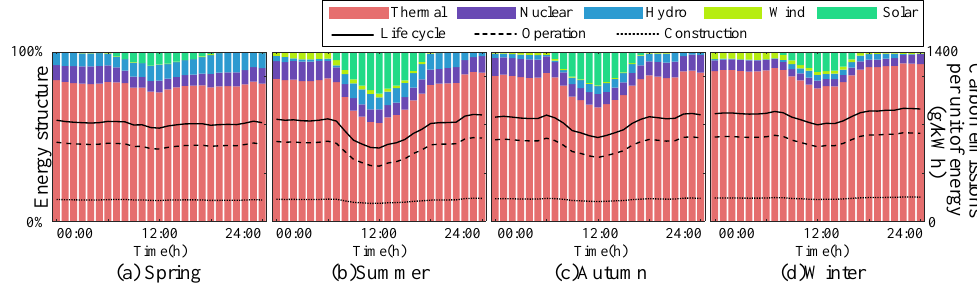
Figure 4. Carbon emissions results and generation proportion of different energy sources in four seasons.